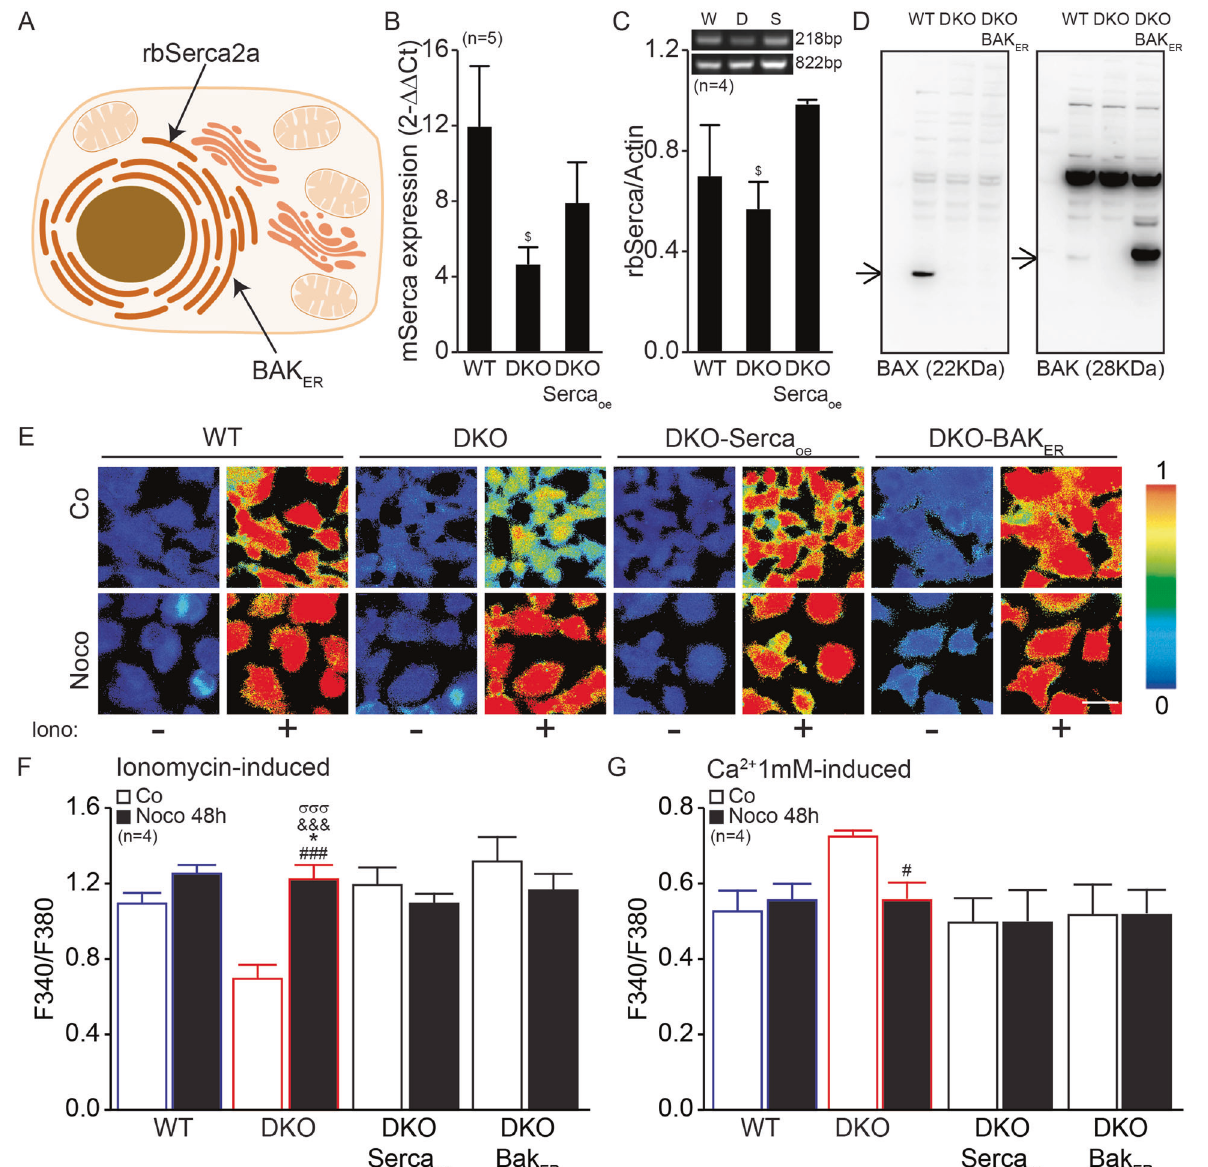
( B , D ) were seeded and treated or not with 100 nM Nocodazole (Noco) for 48 h. Then, cells were MEFs were loaded with 4 µM Fura2/AM and subjected to fl uorescence imaging of cytosolic Ca 2 + ( E ). Ca 2 + store content ( F ) was evaluated by perfusing cells with 100 nM ionomycin (Iono) for 1 min. Store-operated Ca 2 + entry (SOCE) ( G ) was evaluated by perfusing cells with 10 μ M cyclopiazonic acid for 10 min or 1 µM thapsigargin for 10 min in Ca 2 + -depleted medium. Then, cells were perfused with 1 mM Ca 2 + -containing medium. Bars with blue contours represent WT cells and bars with red contours represent Bax/Bak DKO cells. White columns represent control cells and black columns represent treated cells. Error bars indicate SEM. Data were compared by R software using standard linear model inference, “ lm ”